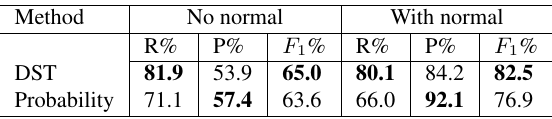
Table 2. Accuracy assessment of moving object detection at point level from a mobile laser scanner.